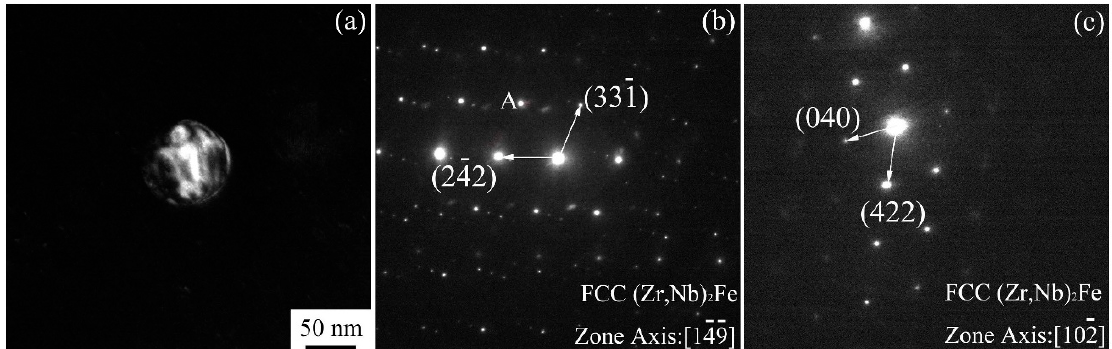
Figure 2. TEM dark field image and corresponding selected area electron diffraction patterns of a particle in Zr alloy #2. ( a ) TEM dark field image from the ‘A’ spot of the SAED (selected area electron diffraction) pattern in ( b ); ( b , c ) SAED patterns from different crystal zone axes.